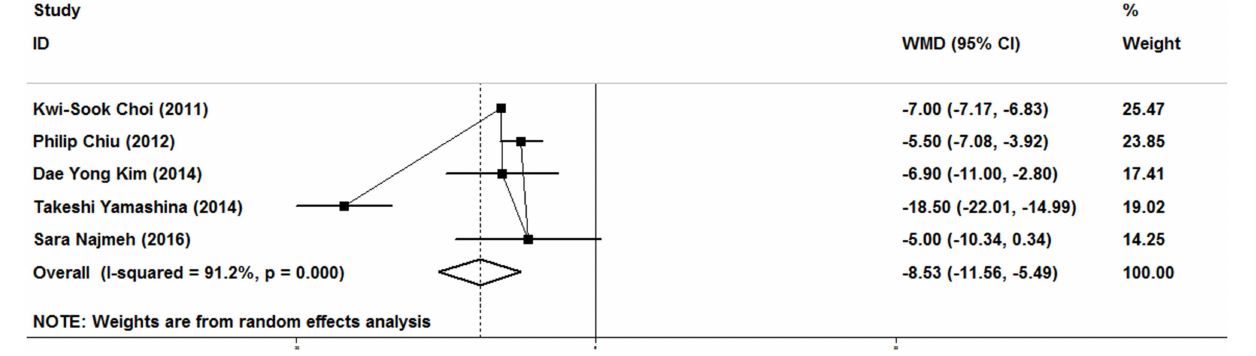
Frontiers in Oncology |